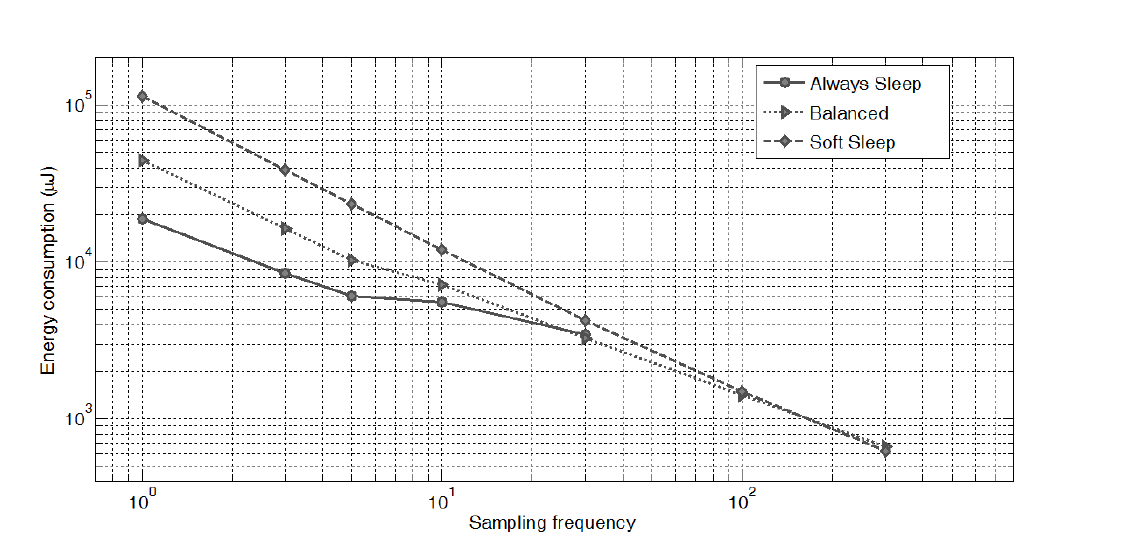
Energy consumption evaluations of the node’s overall energy consumption (per